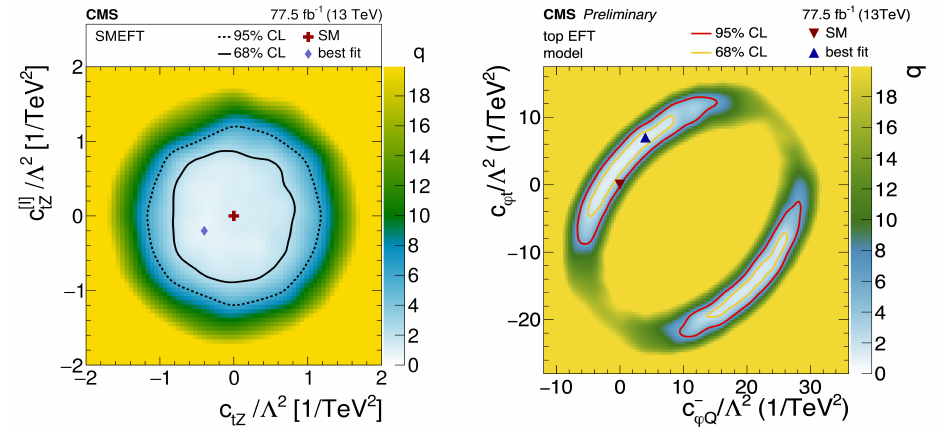
[ I ] and c Φ t with c ¯ Φ Q Wilson coefficients tZ